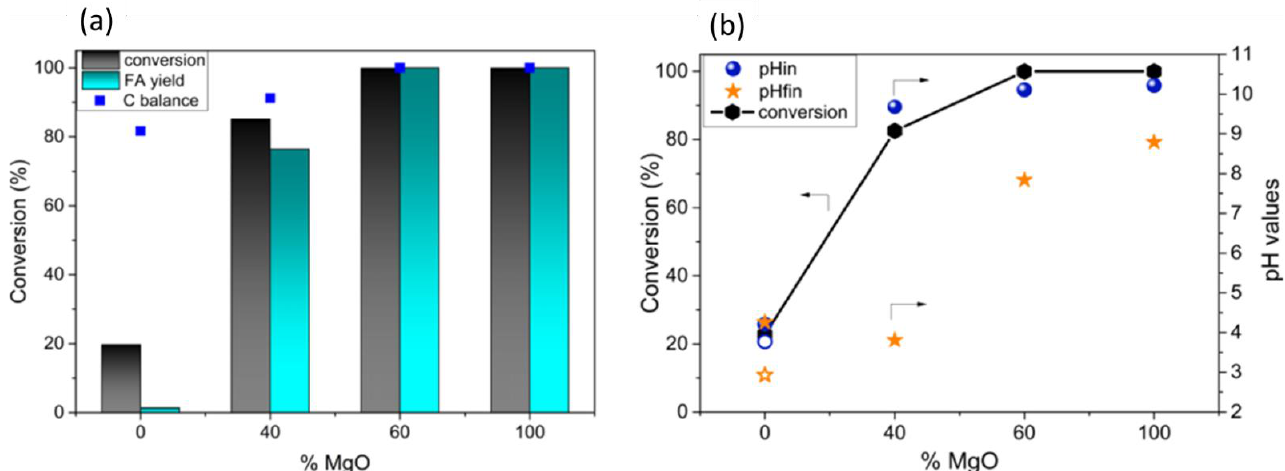
Figure 4. Base-free furfural oxidation using Au-based catalysts supported on the MgF 2 -MgO with various relative amounts of MgF 2 and MgO. ( a ) Furfural conversion and FA yield versus % MgO; ( b ) furfural conversion and initial and final pH values versus % MgO (solid symbols) and blank test (open symbol) ( 49.4 μmol, substrate/metal = 50 (mol/mol), air (26 bar), 110 °C, 600 rpm, 2 h ). pH in indicates the pH measured before reaction (furfural solution + catalyst) and pH fin indicates the pH measured after reaction. Reprinted with permission from Ref. [29].